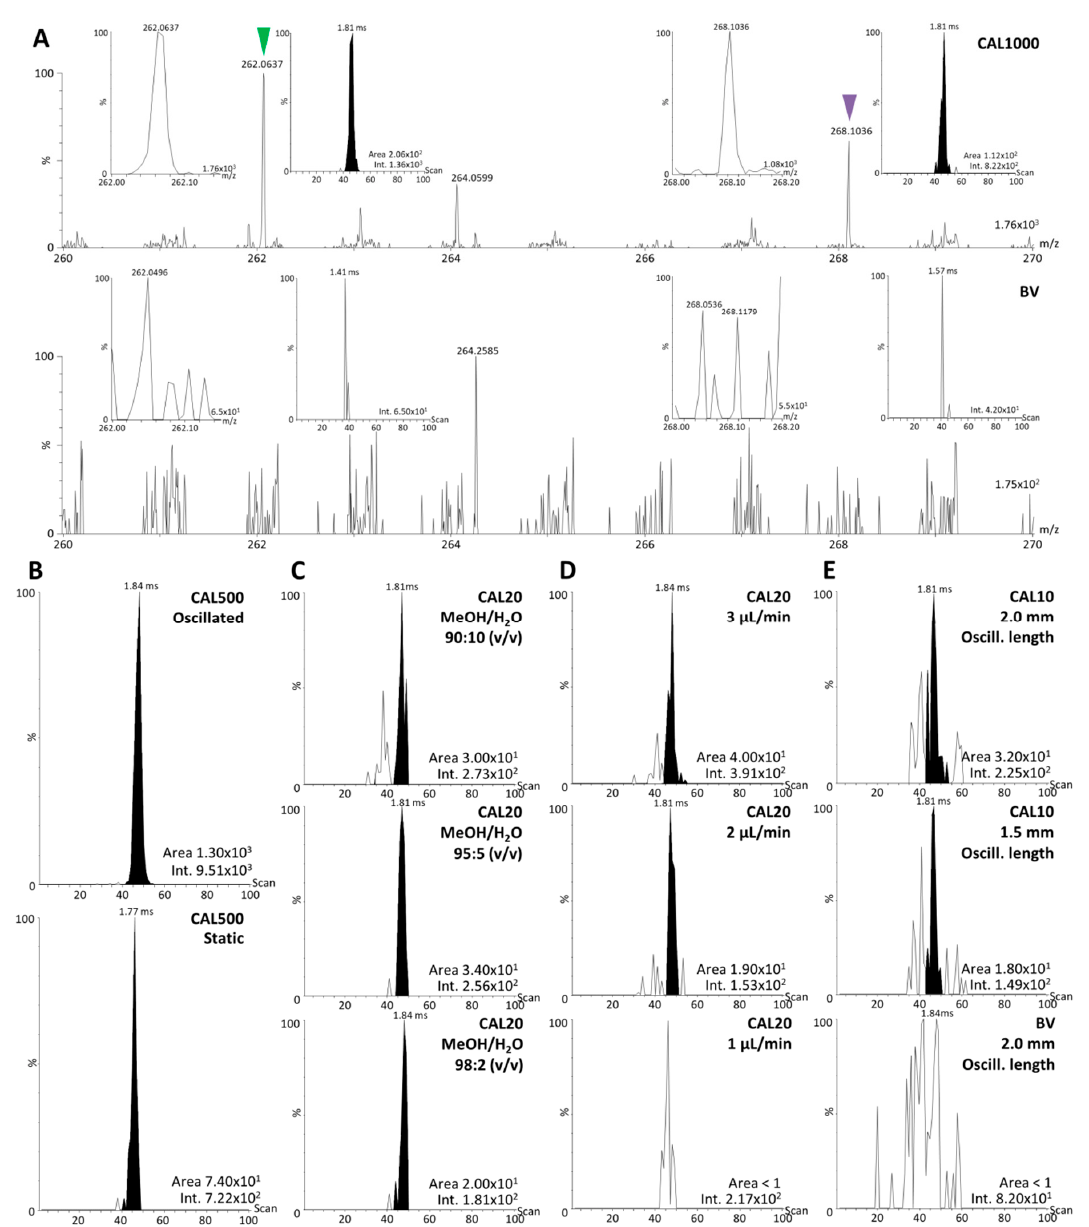
Figure 4. Optimization of ulixertinib (ULN) signal during desorption electrospray ionization (DESI) analyses of mouse brain sections. ( A ) Specificity of ULN DESI signal in tandem MS spectra between a CAL1000 sample (ULN spiked at 1000 ng/g on mouse brain section) and a blind value (BV) sample (blank mouse brain section). Insets show zoomed views on ULN and ULN-d 6 peaks and related extracted ion mobilograms (XIM). ( B ) XIM from CAL500 samples showing signal improvement using spray oscillation versus static spray. ( C ) XIM from CAL20 showing signal optimization using different MeOH/H 2 O ratios (i.e., initial ratio: 98:2, 95:5, 90:10). ( D ) XIM from CAL20 showing signal optimization using different solvent flow rates for spraying. ( E ) XIM from CAL10 samples showing optimization of ULN signal by increasing oscillation length and enabling a better detection of ULN at the targeted lower limit of quantification (10 ng/g). Related area and intensities are given on the bottom right of each spectrum and XIM.